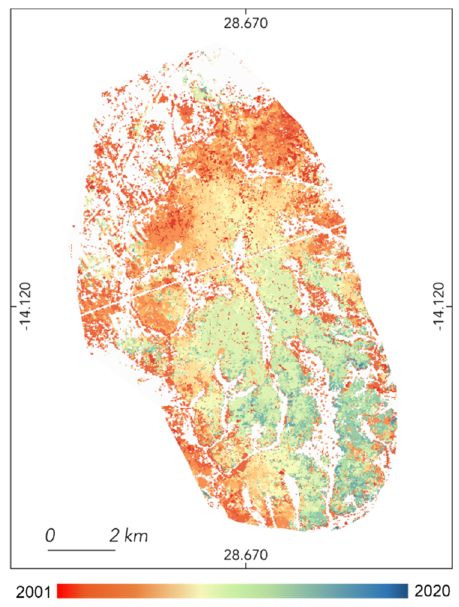
Figure 4. Evolution of annual forest degradation extent in Kapiri Mposhi forest reserve from 2001